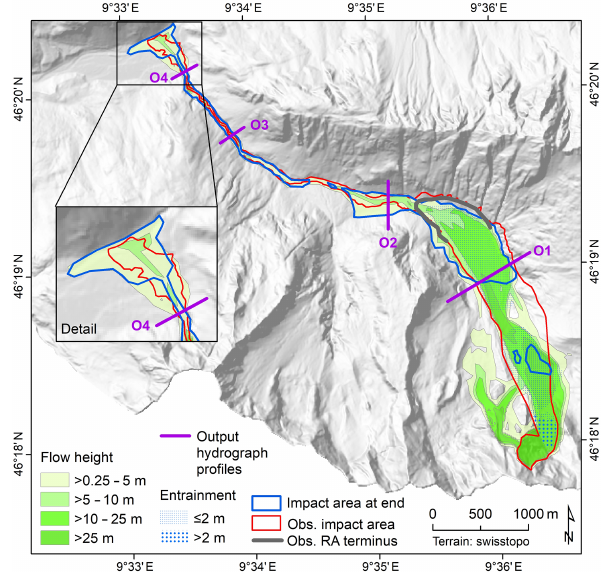
Figure 7. Overview of the heights and entrainment areas as well as the zonation performed as the basis for the simulation with r.avaflow. Injection of pore water only applies to Scenario A. The zones A–F represent areas with largely homogeneous surface char- acteristics. The characteristics of the zones and the model parame- ters associated to each zone are summarized in Table 1 and Fig. 4. O1–O4 represent the output hydrograph profiles. The observed rock avalanche terminus was derived from WSL (2017).